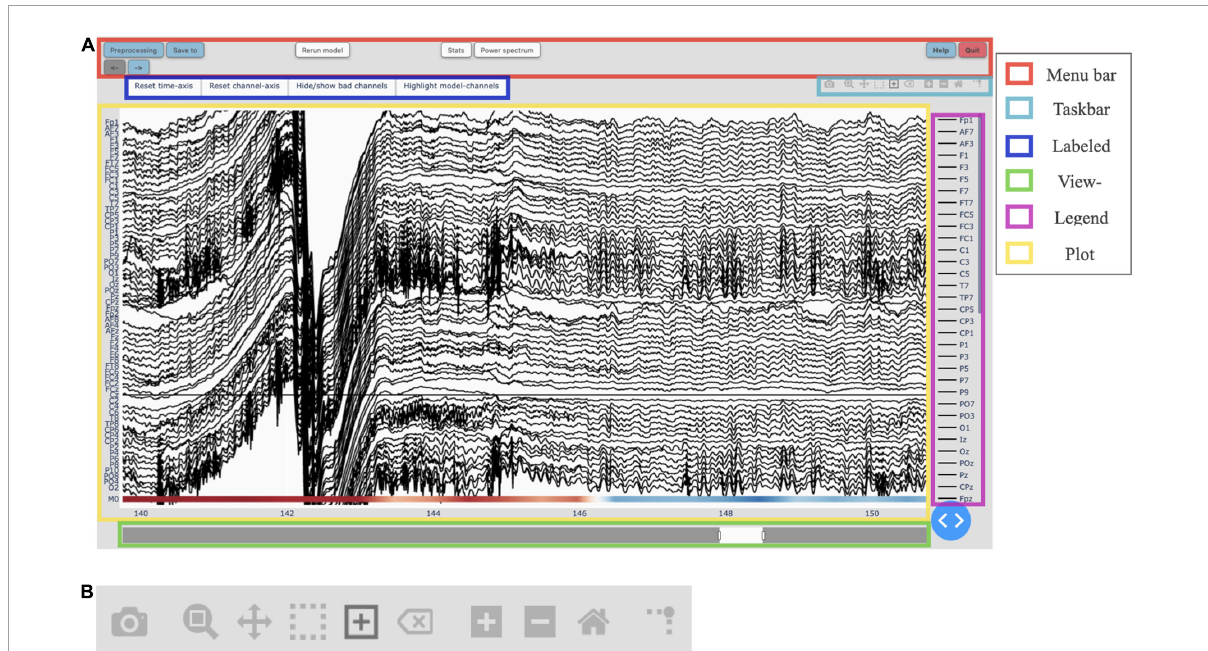
FIGURE2 (A) The main graphical user interface (GUI) of Robin’s Viewer (RV) with its six subsections highlighted [see Section “3.3 Graphical user interface (GUI)”]: The menu bar ( red ) contains buttons to open pop-up windows for file loading and preprocessing, saving, annotation statistics, power spectrum, help, and shutting down RV, as well as a button to recalculate the deep-learning model’s predictions (if activated) and left and right arrow buttons used to navigate the currently viewed timeframe (if the data is loaded in segments). The taskbar ( light blue ) seen in detail in panel (B) . The labeled buttons ( dark blue ): The first two buttons are used to reset the view, either across the channel- (“Reset channel-axis”) or time-axis (“Reset time-axis”). The third button (“Hide/show bad channels”) allows to hide marked bad channels from the plot. The fourth button (“Highlight model-channels”) only appears when deep-learning predictions are activated and highlights the channels used by the model to make its predictions in blue. The view-slider ( green ) is used to scroll continuously along the time-axis of the signal. The legend ( purple ) shows all available channels. Clicking on any channel in the legend once will hide it from the plot (clicking again reverses this). Double-clicking on a channel will hide all other channels from the plot, except for the selected channel. The plot ( yellow ) shows the traces for all selected channels spread across the vertical axis, and time (in seconds) on the horizontal axis. The user can hover over any given point in the plot in order to display the time (in seconds) and amplitude (in µ V if no custom scaling was used) values of the trace under the mouse. The deep-learning predictions, if activated (see Section “3.5 Deep-learning model predictions”), are plotted below the EEG traces. (B) The taskbar hosts ten buttons from left to right: (1) Take a picture of the (annotated) electroencephalography (EEG) signal and download it as a .png file. (2) Select an area to zoom in on. (3) Move view along the channel- or time-axis. (4) Select a channel to mark it as “bad” or select a segment of the data for which to calculate and display the main underlying frequency and power spectrum. (5) Select a segment of the plot to annotate. (6) Delete the currently selected annotation. (7) Zoom in one step. (8) Zoom out one step. (9) Zoom out as much as necessary to show all channels for the entire duration of the recording (or segment). (10) Display a ruler from both axes to the datapoint currently hovered